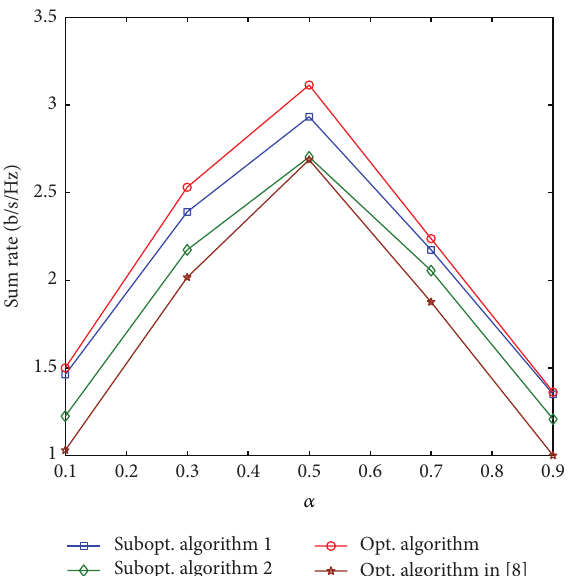
Figure 3: Sum rate versus the location of the relay. The parameters are set to be 𝐷 = 150 m, 𝑃 𝑆 = 𝑃 𝑅 = 3 W, = 𝑇 = 0.15 W, and 𝑁 = 14 . Figure 3 illustrates the sum 𝑇 1 2 rates of the four algorithms versus the location of the relay.